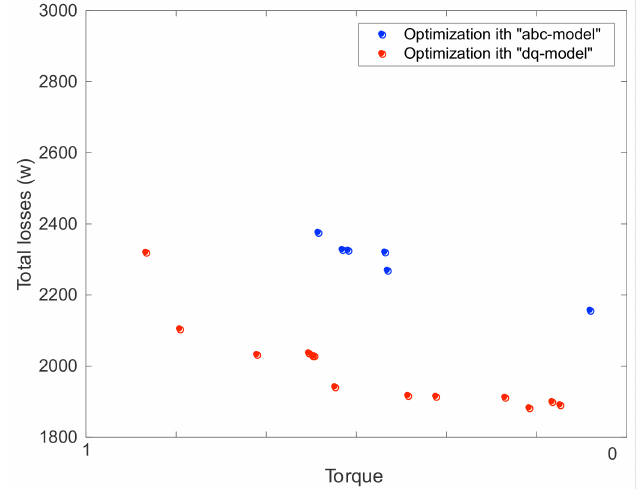
Figure 18. Pareto Front for machines with 34 kg: “abc model” vs. “dq model”.